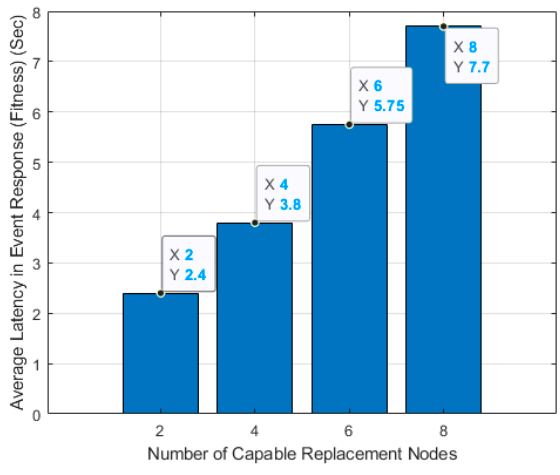
Figure 15. Average latency in event response (fitness computation).